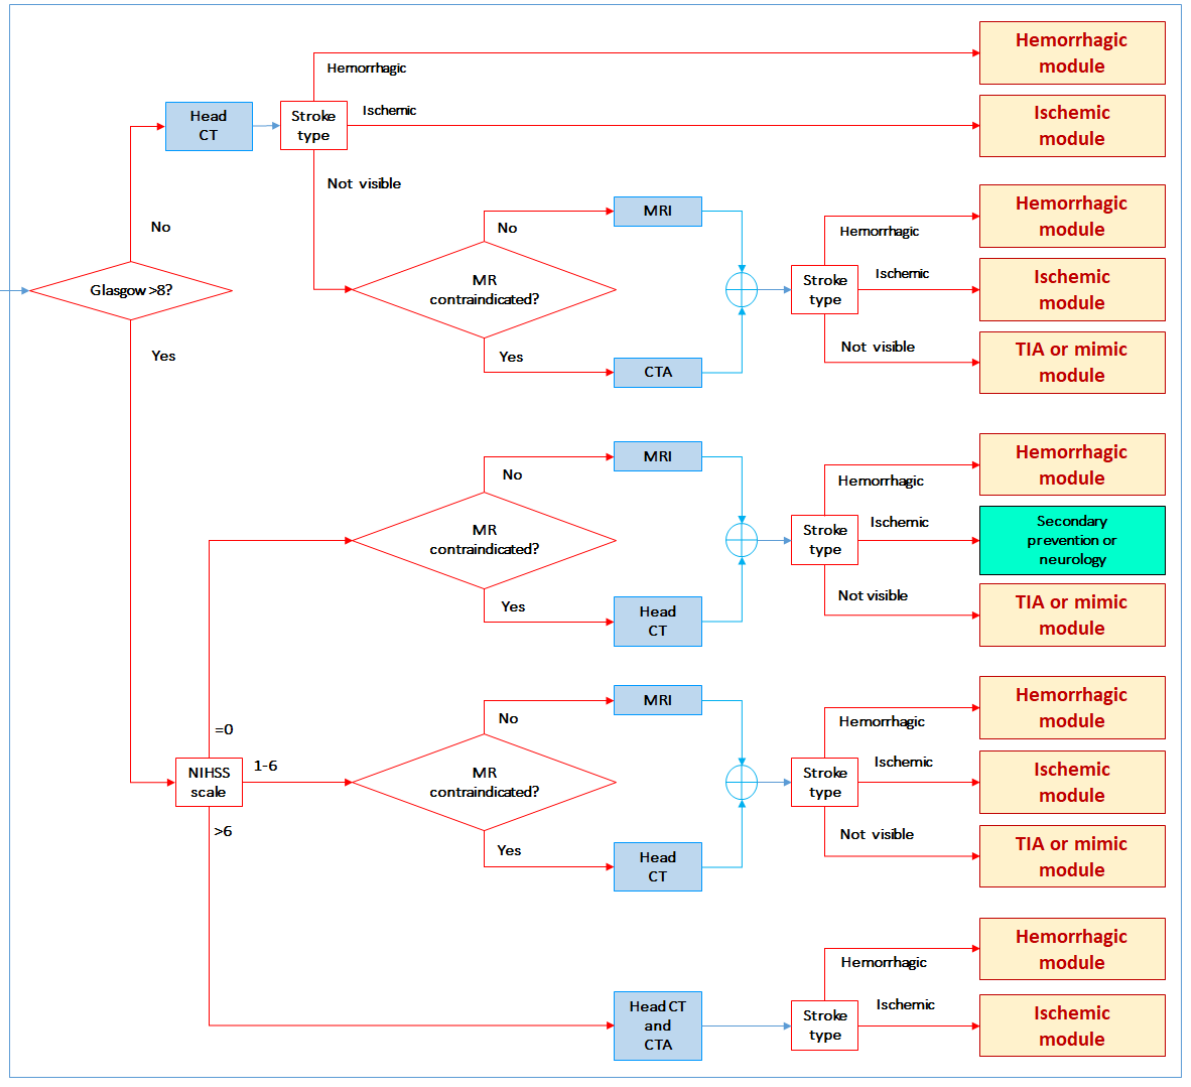
Figure 6. Within window module for the advanced health care setting. CT: computed tomography; CTA: computed tomography angiography; Glasgow: Glasgow Coma Scale; MR: magnetic resonance; MRI: magnetic resonance imaging; NIHSS: National Institutes of Health Stroke Scale; TIA: transient ischemic